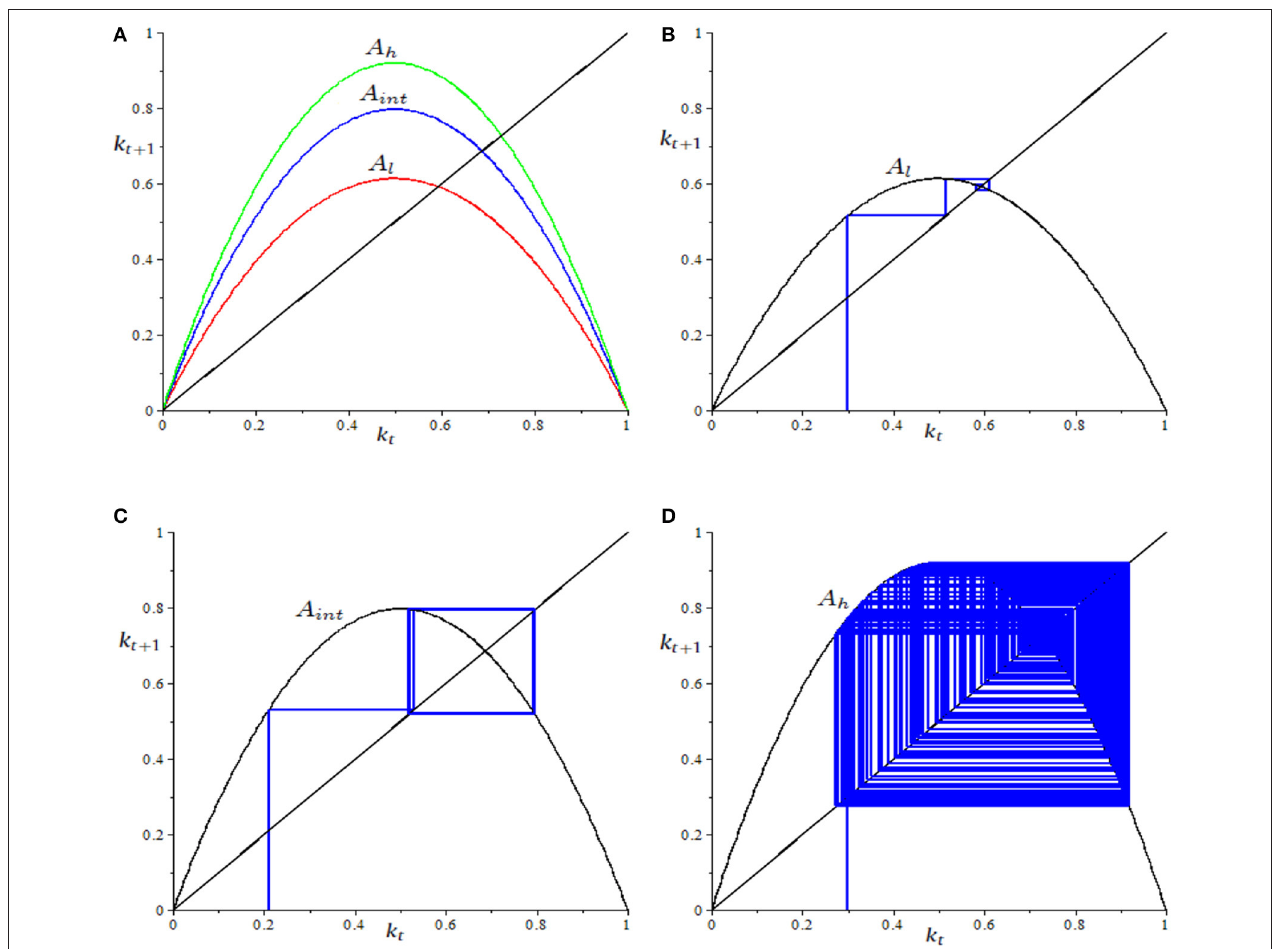
FIGURE 1 | Parameter set: σ = 0.5, λ = 0.02, A l = 5, A int = 6.5, A h = 7.5. (A) Changes in the shape of the map, as A varies. (B) Convergence to the fixed point for A = A l ( k 0 = 0.3). (C) Convergence to a 2-cycle for A = A int ( k 0 = 0.21). (D) Chaotic regime for A = A h ( k 0 =